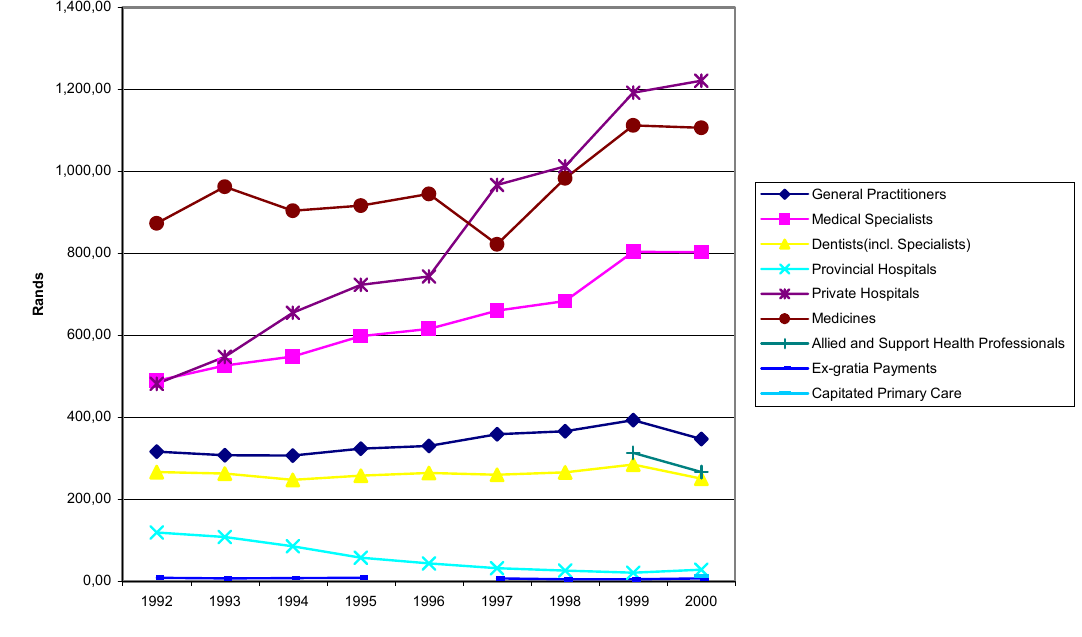
Figure 2: Real cost per beneficiary (constant 2001 prices) Source: Council for Medical Schemes (www